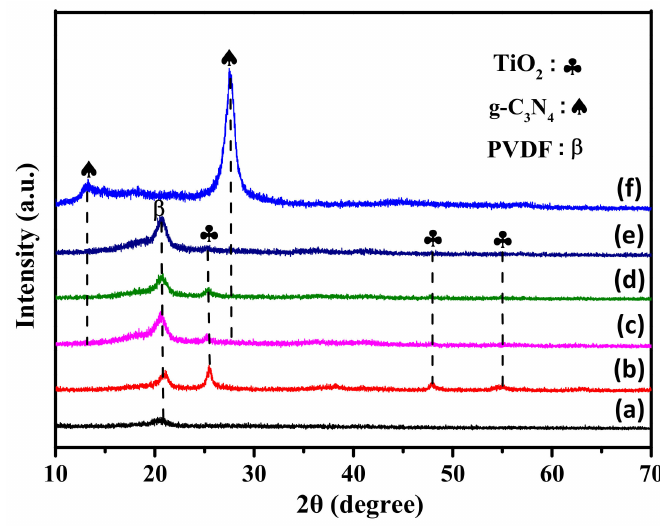
Figure 2. XRD patterns of ( a ) TBOT / PVDF fibers, ( b ) TiO 2 / PVDF fibers, ( c ) TPCN1, ( d ) TPCN2 ( e ) TPCN3 and (f ) g-C 3 N 4